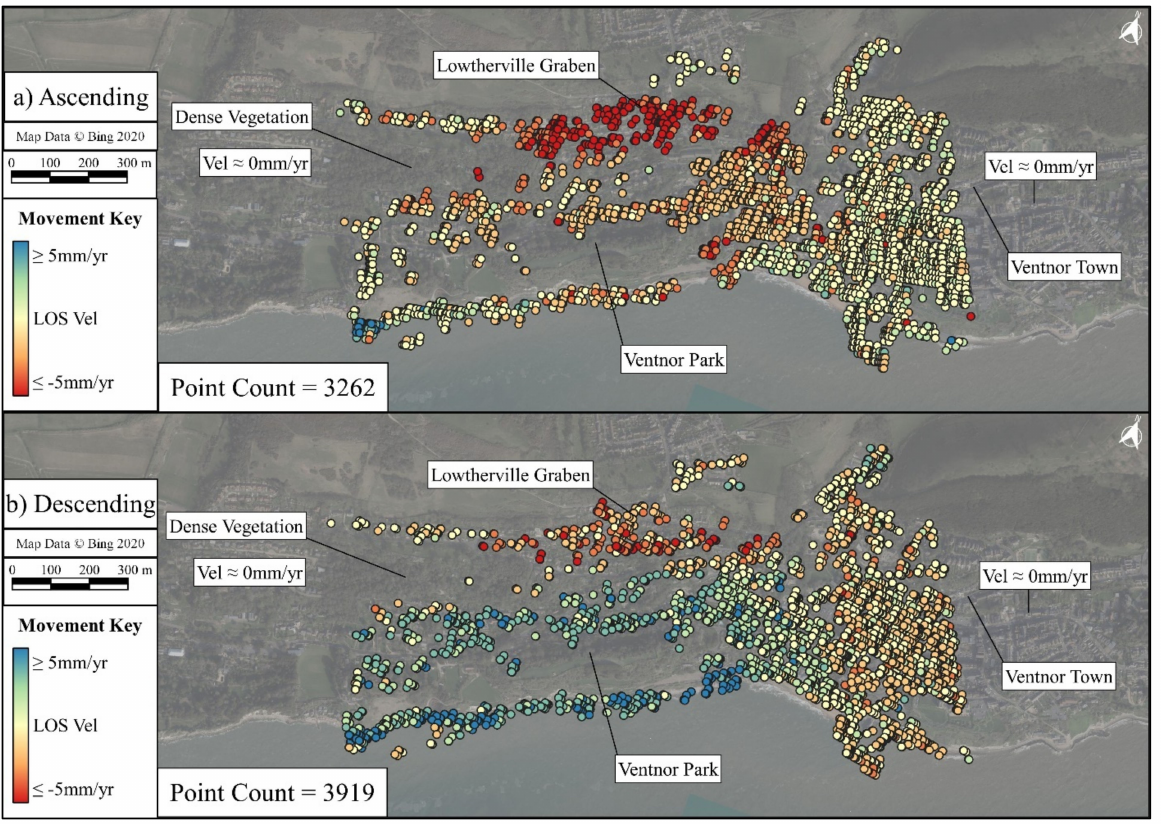
Figure 4. ( a , b ): Distribution of PS points generated from ascending ( a ) and descending ( b ) Sentinel 1 orbits for the Ventnor Scheme 2020.